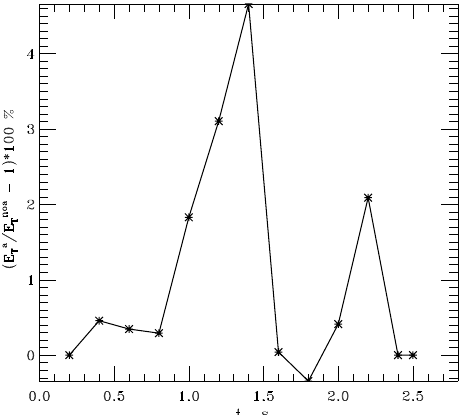
Figure 9. The dependence of the x component (dotted curve), Figure 8. The difference between turbulent kinetic energy averaged y component (dashed curve) and z component (solid curve) of the over time period t in a case without aerosol ( E noa ) and with aerosols averaged kinetic energy on time with aerosol for N tot = 5500cm − 3 T ( E a ), where E T (t) = 1 /t R t TKE (t (cid:48) ) d t (cid:48) . All other parameters are 0 T the same as in Fig. 7. Table 3. Initial value of supersaturation averaged over the domain S init , total number of particles ( N tot ), number of activated particles ( N act ) at t = 3s, liquid water content (LWC) at t = 3s, change in temperature between start and end of simulation ( (cid:49)T ), change in percentage maximal supersaturation between start and end of sim- ulation ( (cid:49)S max ), change in percentage minimal supersaturation be- tween start and end of simulation ( (cid:49)S min ), the phase relaxation time of supersaturation τ phase at t = 3s for considered cases 1, 2, 3 and 4 (see Table 1). The phase relaxation time τ phase is the numerically predicted value in cases 2, 3 and 4. In case 1 the phase relaxation time is obtained from Eq. (6). No subsaturation is predicted any- where in the domain in all cases. Non-equilibrium case with low intensive turbulence is considered (see Table 2).